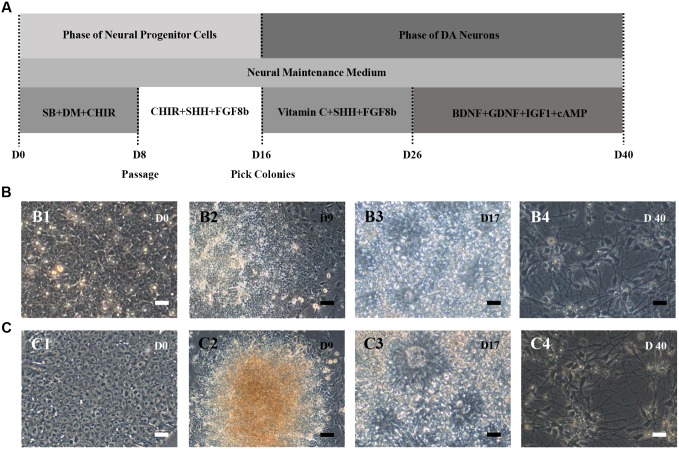
Schematic depicting of dopaminergic (DA) neuronal differentiation from different hESCs lines.
(A) Flow diagram of the differentiation protocol with addition of growth factors/small molecules. (B,C) Morphological changes during neural differentiation. P96 (B) and HN4 (C) cell lines experienced a similar transformation process. (B1,C1) The hESCs cells were cultured onto Matrigel-coated dish and exhibited cobblestone-like shape. (B2,C2) A differentiating human embryonic stem cell colony was observed in HN4 and P96 cells lines. These cells extended short processes and gradually lose hESCs morphology on Day 9. (B3,C3) Neural progenitor cells exhibited neural rosette-like structures on Day 17. (B4,C4) At the end of differentiation, these cells exhibited typical neuronal morphology and formed elaborate neural network on Day 40. Scale bar = 50 μm.